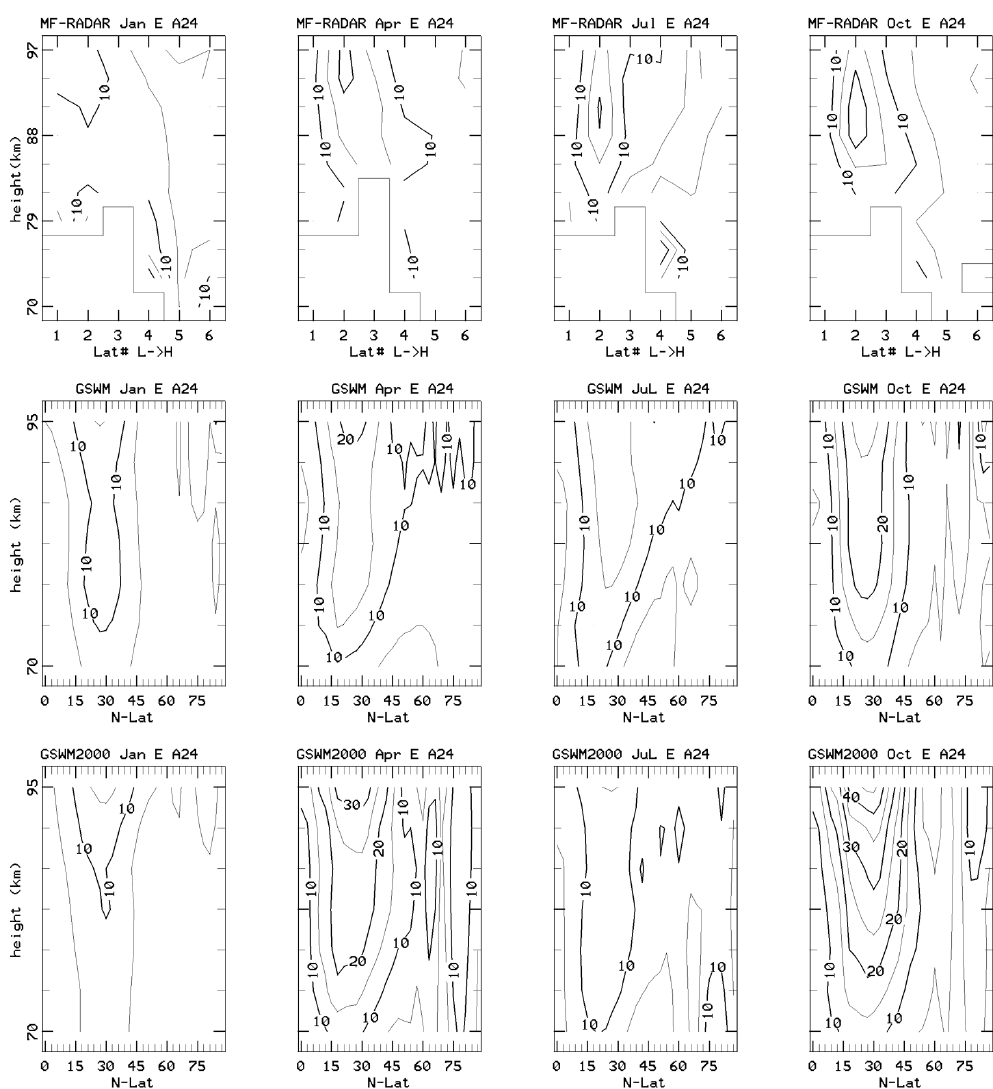
Fig. 9. Amplitude (A24) contour plots for the zonal component of the 24h Tide. Otherwise as for Fig.